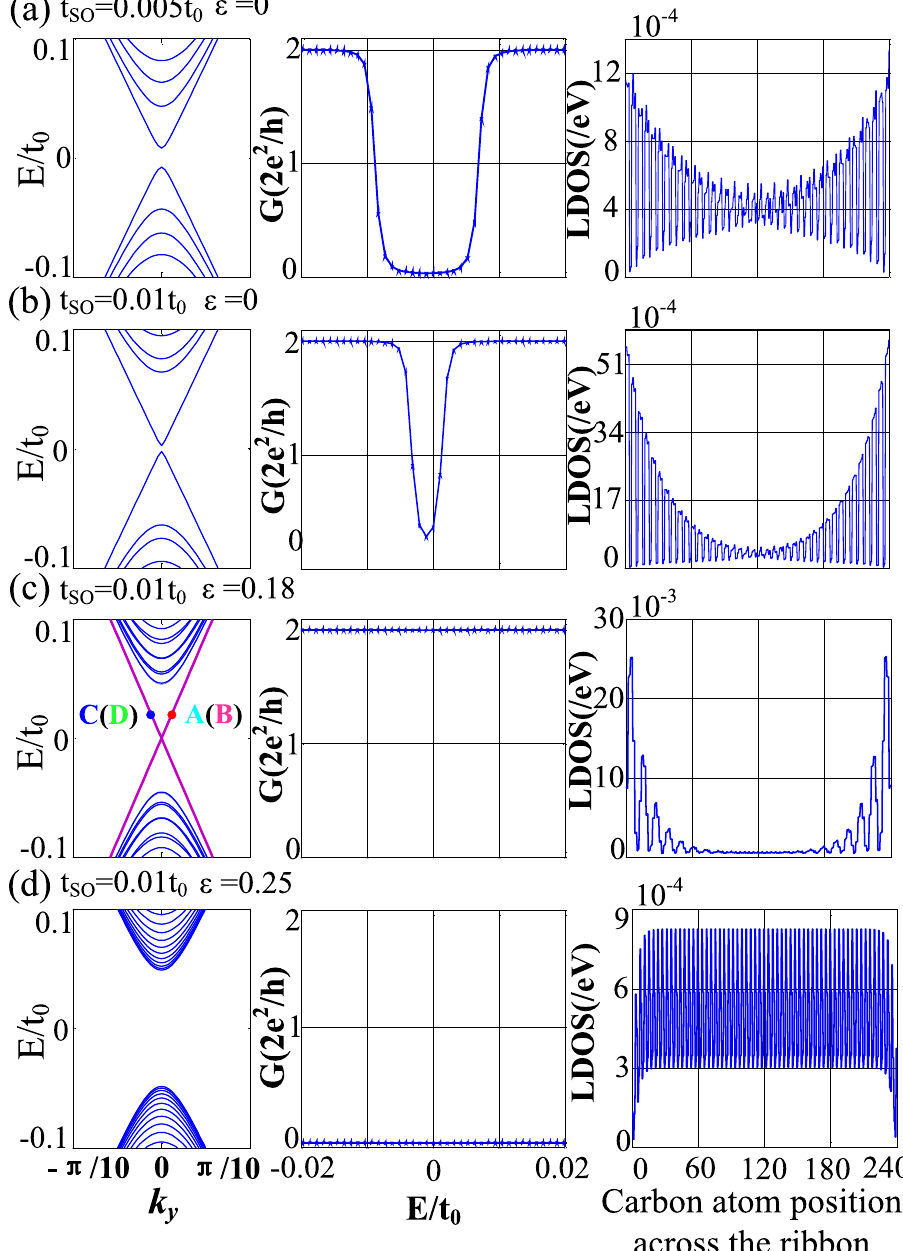
Figure 3. Edge-state band structure, conductivity G and LDOS of armchair GNR for ε = . = t GNR width is set to be 240 carbon